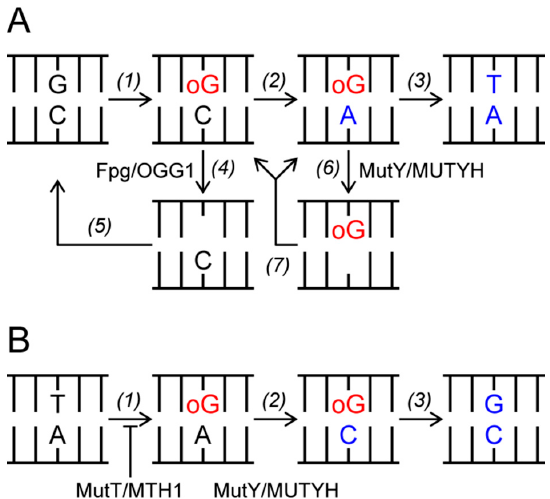
Figure 3. OxoG-induced mutagenesis and the GO system. ( A ) oxoG can appear in DNA through oxidation of G (1) and direct misinsertion of A during replication (2); if not repaired, oxoG:A mispair produces T:A after the second round of replication. OxoG can be removed by Fpg / OGG1 from oxoG:C before the replication (4) and the subsequent BER steps restore the G:C pair (5). Alternatively, after the replication, A can be removed from oxoG:A (6) allowing the repair DNA polymerases to insert either C or A opposite to oxoG (7). ( B ) oxoG can also appear in DNA through incorporation from oxodGTP. If this occurs opposite to A (1), the repair by MutY / MUTYH (2) is mutagenic, causing a T:A-to-G:C transversion (3). MutT / MTH1 hydrolyzes oxodGTP and intercepts this pathway at the